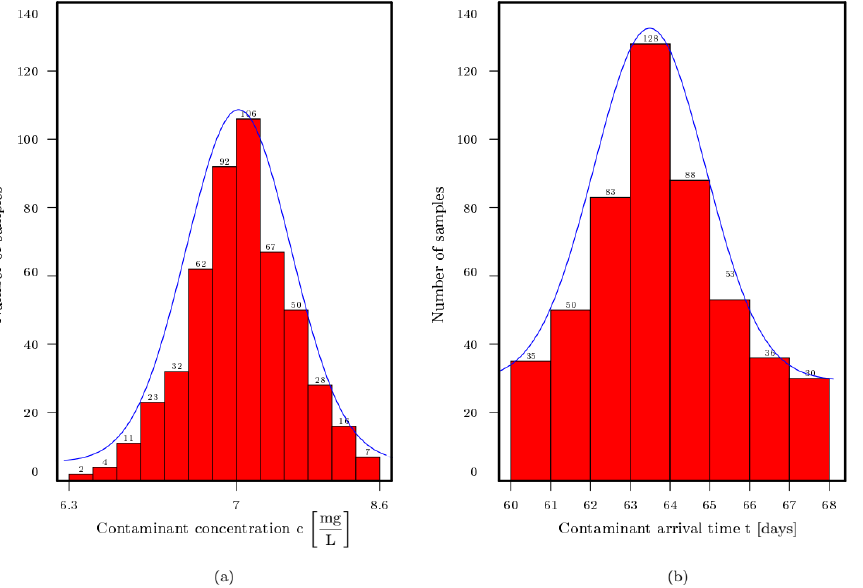
Figure 11. Histograms of ( a ) the average contaminant concentration at t = 140 days, ( b ) contaminant arrival time for the region located between ( 100,15 ) and ( 150,100 )